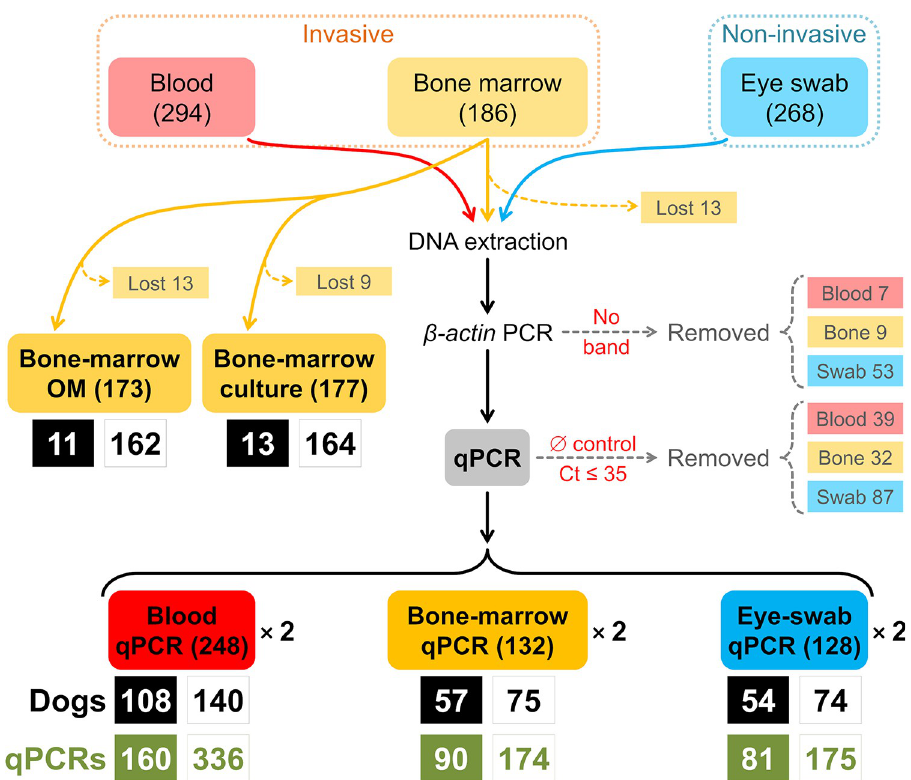
Fig 1. Detecting Leishmania in dogs: Schematic of the sampling-testing process. Invasive samples were taken from 294 (peripheral blood) and 186 dogs (bone-marrow aspirates), and non-invasive samples (conjunctival eye swabs) from 268 dogs. Some bone-marrow samples were lost before processing (indicated by “Lost”); 173 were tested by optical microscopy (“OM”), 177 by culture, and 173 were submitted to DNA extraction for quantitative PCR (“qPCR”). Blood and eye-swab samples were all submitted to DNA extraction. We PCR-amplified the constitutive dog β -actin gene and removed samples yielding no amplification (indicated by “No band” and then “Removed” in the “ β - actin PCR” step). The rest of samples had amplifiable DNA and were used for duplicate Leishmania kDNA qPCR assays; of these, some were not considered further because there was DNA amplification with cycle-to-threshold (Ct) values � 35 cycles in the negative and/or blank controls (“ Ø ”) of their qPCR plates (indicated by “ Ø Ct � 35” and then “Removed” in the “qPCR” step). The results of qPCRs run on plates in which all negative and blank controls had either no amplification or high-Ct amplification ( > 35 cycles) were used for our analyses. These correspond to duplicate qPCRs run on blood (248 dogs, 496 qPCRs), bone-marrow (132 dogs, 264 qPCRs) and eye-swab samples (128 dogs, 256 qPCRs). The results of each diagnostic procedure are shown as the number of positive dogs (black boxes) and qPCRs (green boxes) plus the number of negative dogs and qPCRs (white boxes). Prov (Newprov, Pinhais, Brazil) and observed under a Leica DM500 light microscope with immersion oil and 100 × magnification [45]. We read 1000 fields per slide and scored the OM test as positive if at least one Leishmania amastigote was unambiguously identified in at least one slide. Bone-marrow culture (BMC) . Using sterile insulin syringes, we seeded ~20 μ L of bone-mar- row aspirate into each of two BD Vacutainer tubes containing 5 mL of a base agar preparation (no. 2, Difco 0696–17; BD, NJ), 10% defibrinated rabbit blood (added after agar fusion), and gentamicin 100 μ g/mL (Schering-Plough, Kenilworth, NJ) [46]. The tubes had been sealed and stored in an oven at room temperature for 24 h to check for bacterial or fungal contamination, and then stored at 4˚C until use. Seeded culture tubes were checked for Leishmania every two days (over a 30-day period) using a Leica DMi1 inverted optical microscope [46]. This BMC diagnostic procedure was scored as positive when at least one Leishmania promastigote was unambiguously identified in at least one inverted-microscope reading.